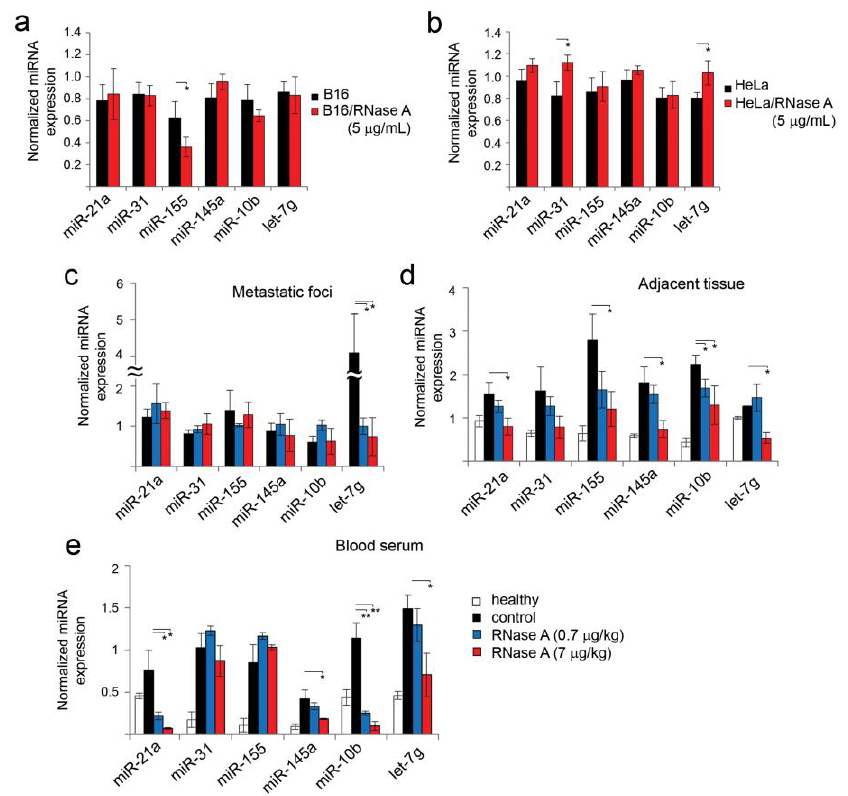
Figure 7. Influence of RNase A on miRNA expression in HeLa and B16 cells in vitro and in vivo. RT-qPCR data. Expression of miRNAs in B16 ( a ) and HeLa ( b ) cells incubated with RNase A (5 µ g/mL) for 48 h under standard conditions. The levels of miRNA in metastatic foci ( c ), adjacent tissue ( d ) and blood serum ( e ) of mice with melanoma B16 received daily RNase A at the doses of 0.7 and 7 µ g/kg. The level of miRNA expression in lung tissue and metastatic foci was normalized to U6 snRNA. Data of miRNA levels in healthy lung tissue were used as control for tissue adjacent to metastatic foci. The concentration of miRNA derived from serum was normalized to serum volume. miRNA levels in blood serum of healthy mice did not exceed 0.2–0.4. Data are presented as mean ± S.E.M. Data were statistically processed using Student´s t -test; * p < 0.05, ** p < 0.01.